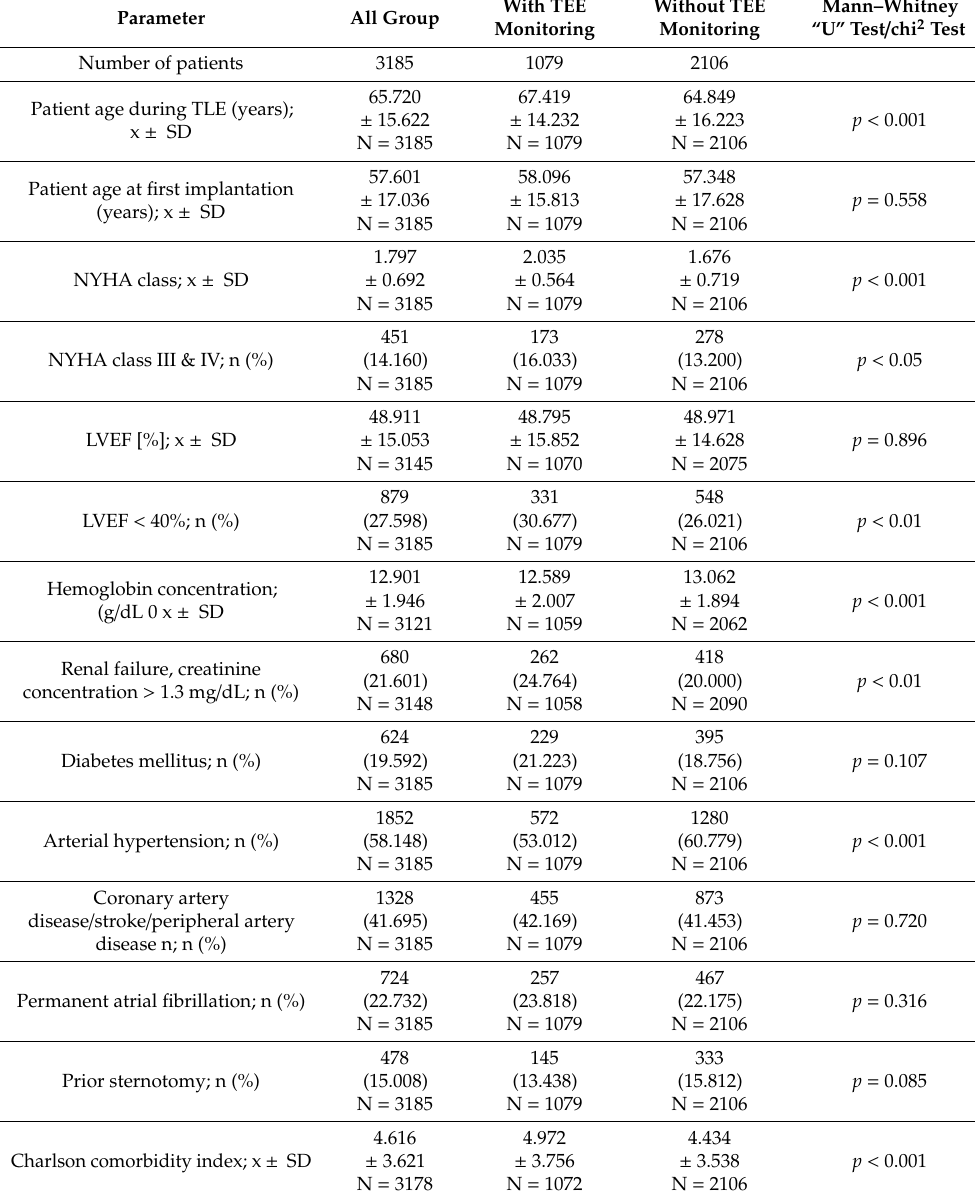
Table 1. Demographic and clinical